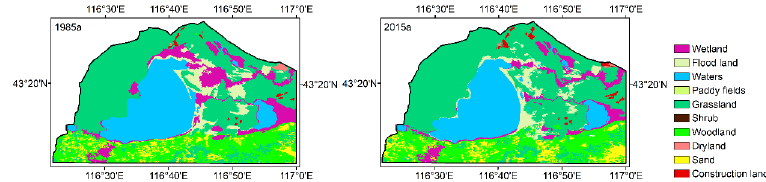
Figure 2. Temporal and spatial evolution of the land use in Dalinor